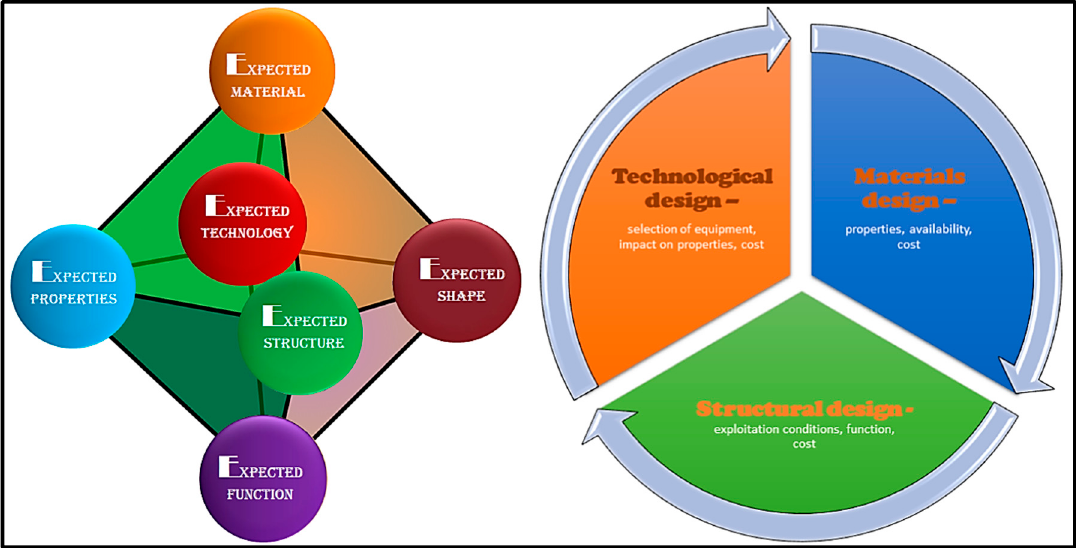
Figure 5. Fundamentals of engineering design: 6 × E rule’s octahedron; synergy of material, technological and structural design.